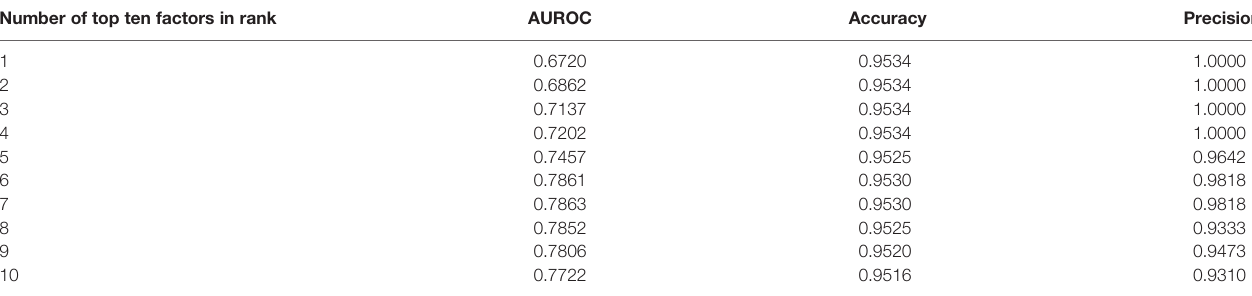
TABLE 3 | The areas under the receiver operating curve (AUROC), accuracy and precision with the cumulating number of top ten factors in an ascending order. Number of top ten factors in rank